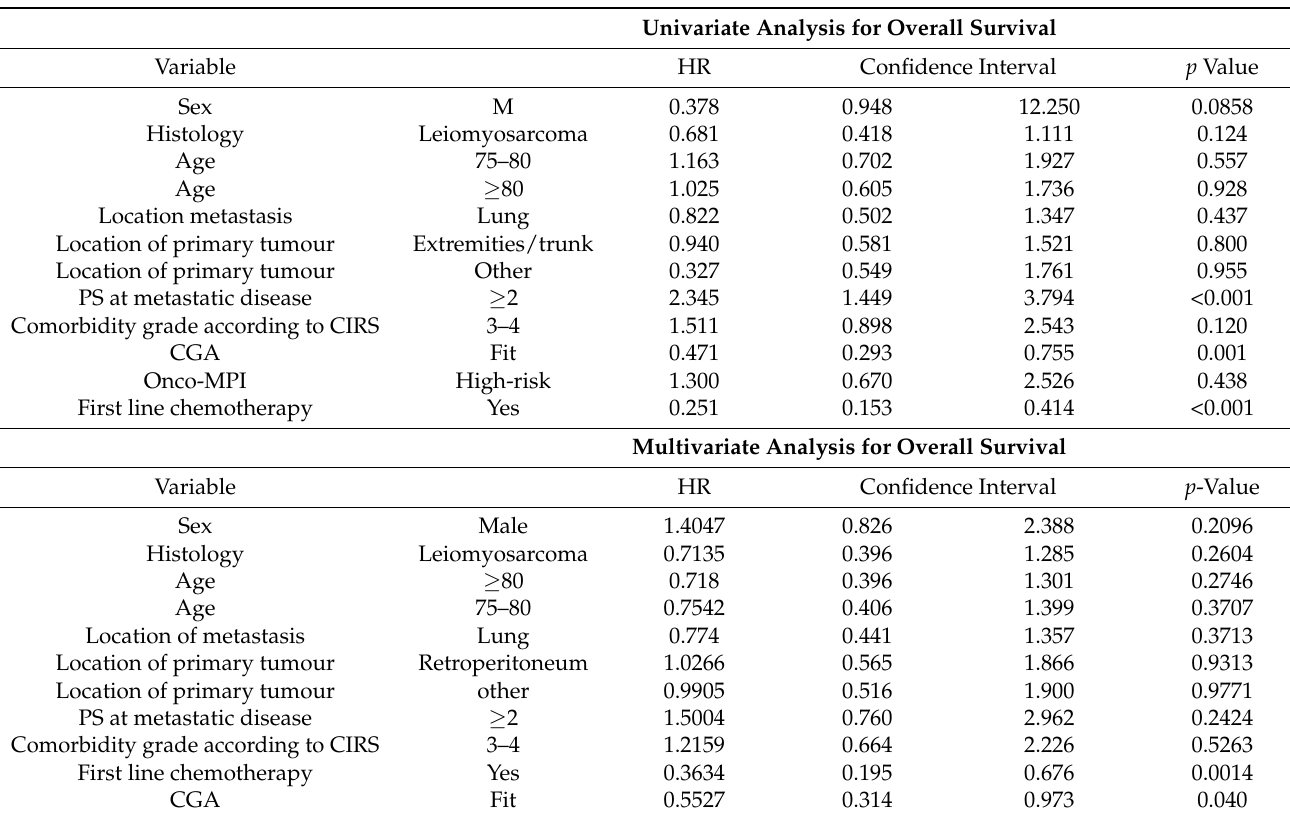
Table 5. Univariate and multivariate analysis for overall survival. Univariate Analysis for Overall Survival